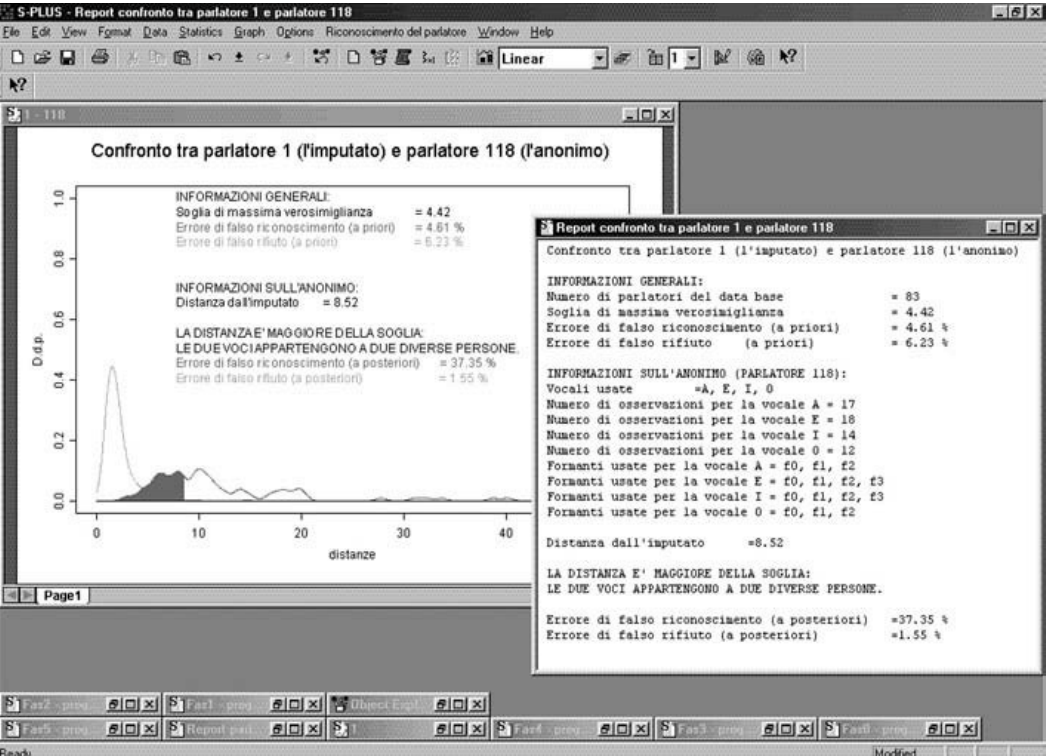
Figura 4 – Finestra relativa alla fase di riconoscimento: risultato del confronto, basato sulle vocali “a”, “e”, “i”, “o”, tra parlatore “1” e parlatore